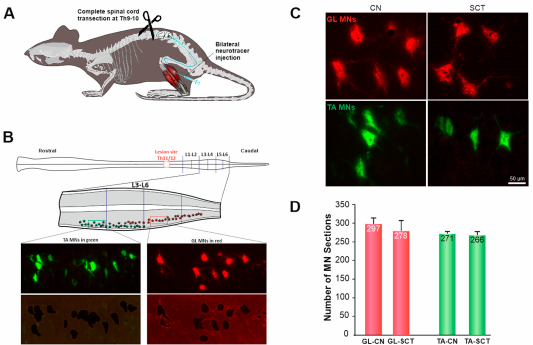
Figure 1. Experimental procedures ( A , B ), morphology ( C ), and number ( D ) of GL and TA MN sections isolated from the intact (CN) and spinalized (SCT) rats. A: The GL and TA MNs in the spinal cord were traced with intramuscularly injected Alexa Fluor 555- (GL) and Alexa Fluor 488 (TA) conjugated cholera toxin subunit B (CT-B). Two weeks later, the rats received a complete transection of the spinal cord at the thoracic T9–10 vertebrae level. B: Schematic of the spinal cord with the lesion site (marked in red) at the T11/12 segments and the lumbar segments under study; the distribution of GL MNs (red) and TA MNs (green) in L3–6 is shown on the diagram enlargement (middle panel). Lower panel: representative photomicrographs showing GL and TA MNs before laser microdissection and the tissue section remaining after microdissection. The traced neurons are also shown enlarged in Figure 1C, documenting that the morphology and size of MNs are comparable between